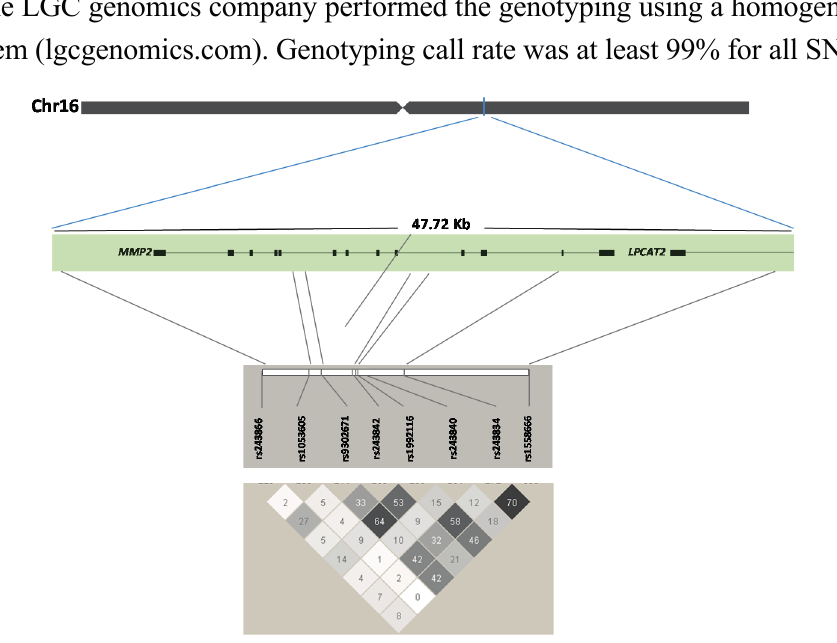
Figure 1. Structure of MMP2 gene on chromosome 16, position of 8